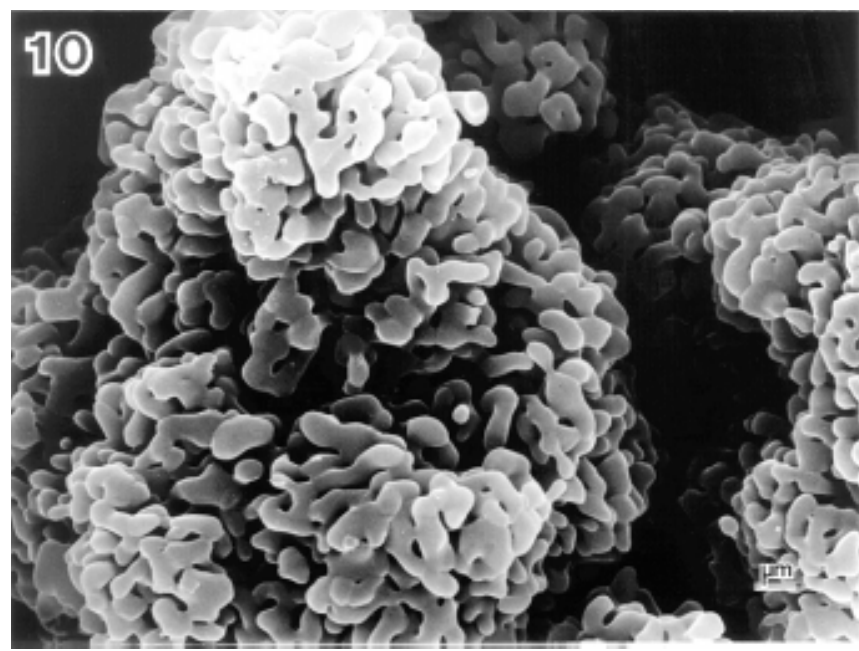
Fig. 10 – SEM of several agglomerates of alpha-alumina after being heated at 1500 ◦ C.